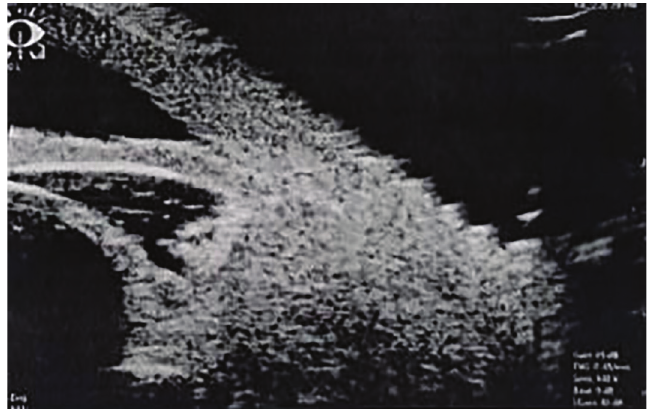
Figure 3 - Ultrasound biomicroscopy shows plus tissue of inhomogeneous echo density with irregular shape and hyperechoic density, the edges towards the posterior chamber are indistinct.